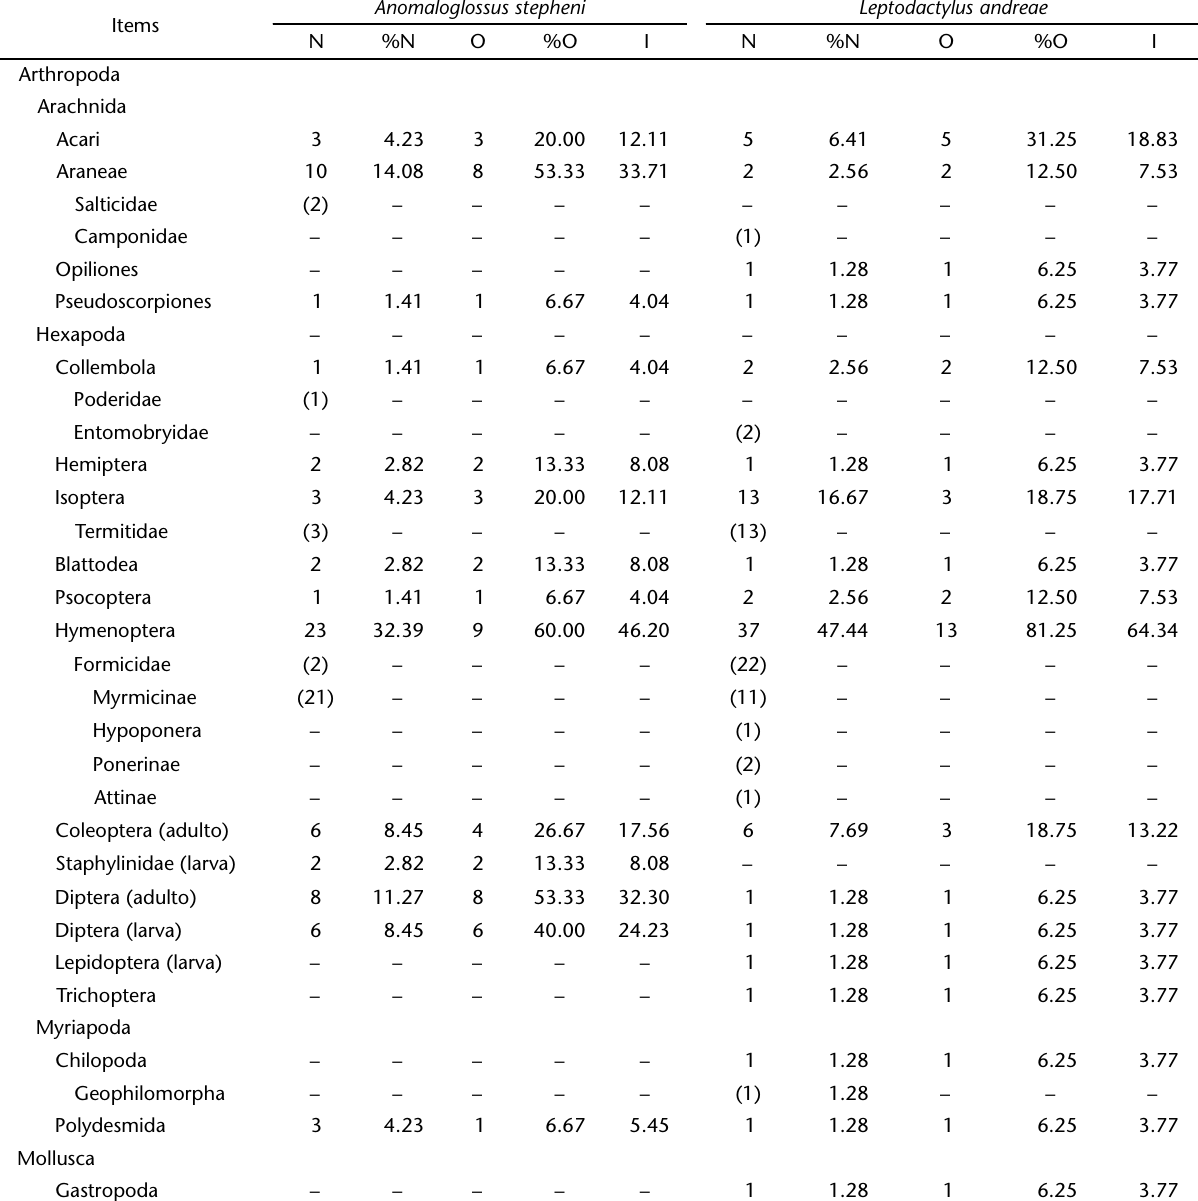
Table I. Prey categories, their respective absolute values, relative abundance (N and %N), occurrence (O and %O), and Index of Importance of preys (I) for Anomaloglossus stepeni and Leptodactylus andreae living in leaf-litter of Central Amazon. Numbers in parenthesis are for taxa below of